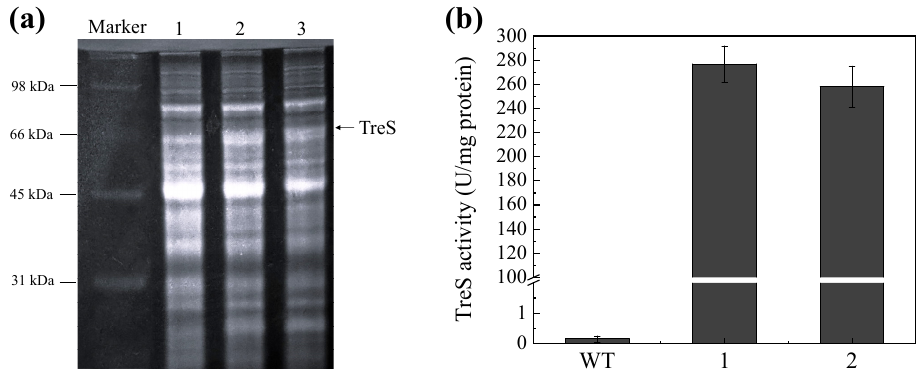
Figure 1. ( a ) SDS-PAGE analysis of recombinant TreS expression: Lane 1, the crude extract of the C. glutamicum ATCC13032; lane 2, the crude extract of the C. glutamicum /pXMJ19- Cgtrs with IPTG induction; lane 3, the crude extract of the C. glutamicum /pXMJ19(- lacI q )- Cgtrs without induction. ( b ) TreS activities from C. glutamicum ATCC13032 (WT), C. glutamicum /pXMJ19- Cgtrs (1), and C. glutamicum /pXMJ19(- lacI q )- Cgtrs (2). The error bars represent the standard deviation of three independent replicates.